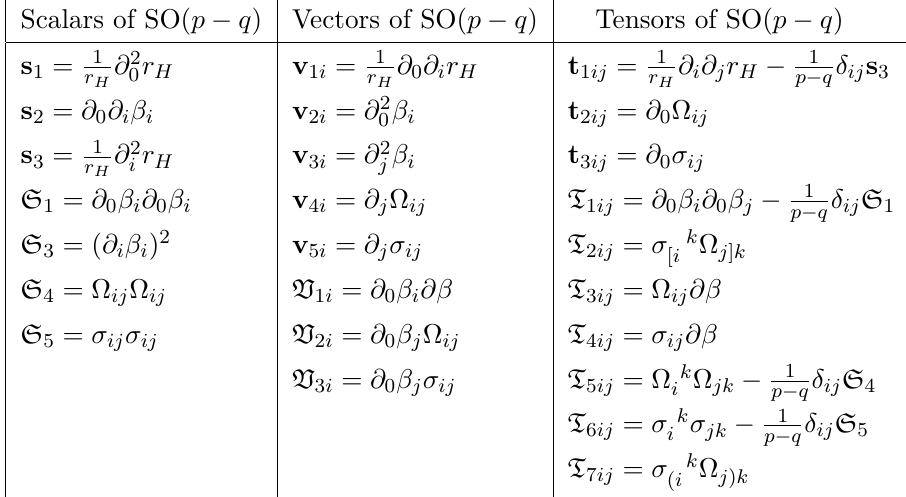
Table 1 . All the SO( p − q ) invariant second-order viscous terms for the relativistic fluid which is dual to compactified AdS black hole. Here p ≥ 2 and 1 ≤ q ≤ p − 1